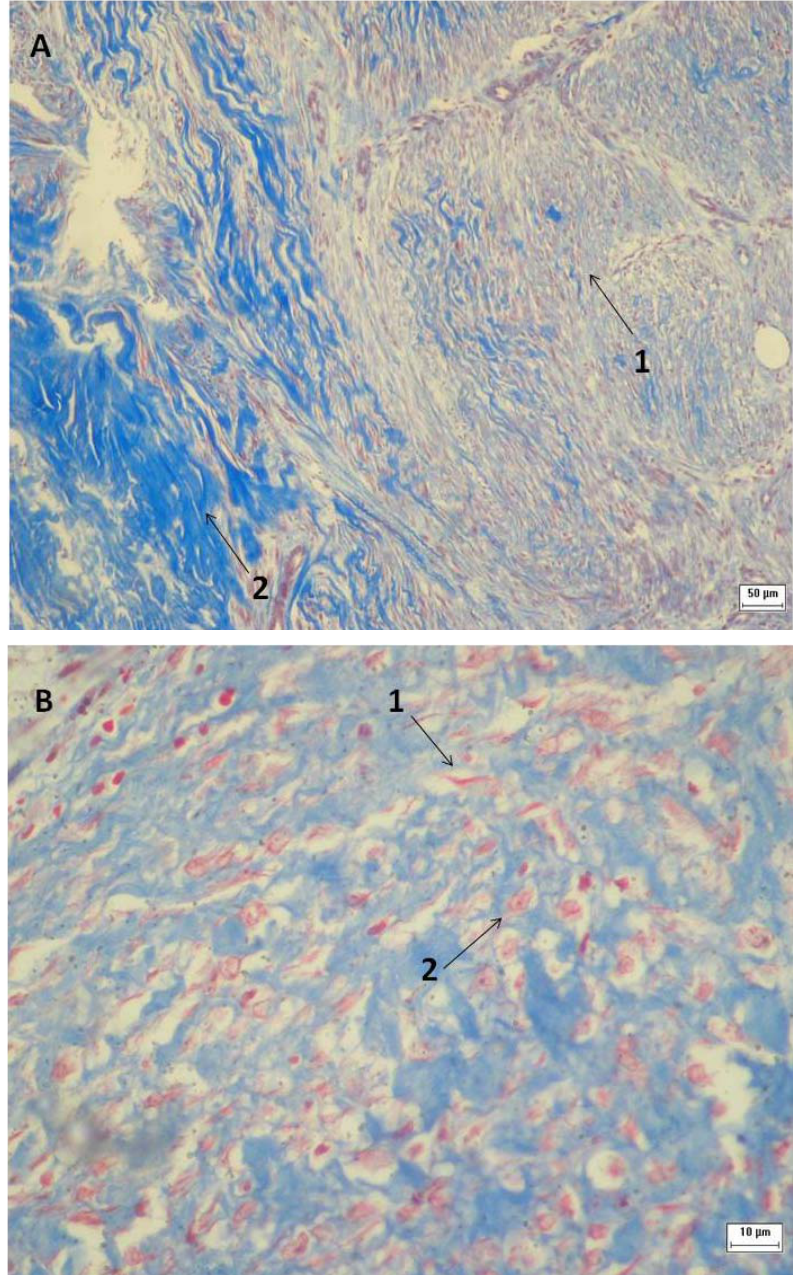
Figure 4. Venous ulcer histology. The tissues in samples A and B were stained with Masson’s trichrome, while sample C was stained with picrosirius red. Samples A, B and C were obtained prior to (1 → 3)- β -glucan treatment. The magnifications shown are as follows: 100 × for samples A and C; 400 × for sample B. ( A and C ) Arrow No. 1 indicates new collagen deposition in the ulcerated area and arrow No. 2 indicates senescent collagen deposition deep within then venous ulcer. ( B ) Arrow No. 1 indicates senescent fibroblast and arrow No. 2 indicates young fibroblast amid collagen deposition in the ulcerated